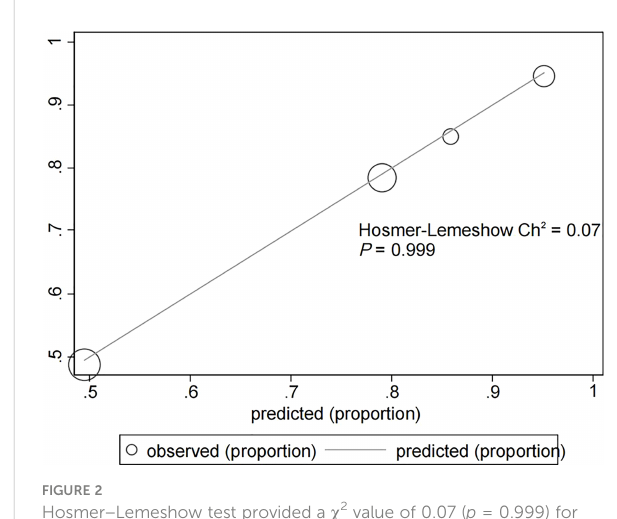
FIGURE 2 Hosmer − Lemeshow test provided a c 2 value of 0.07 ( p = 0.999) for the predictive model in the experimental cohort, suggesting that the model presented a good fi t for the observed